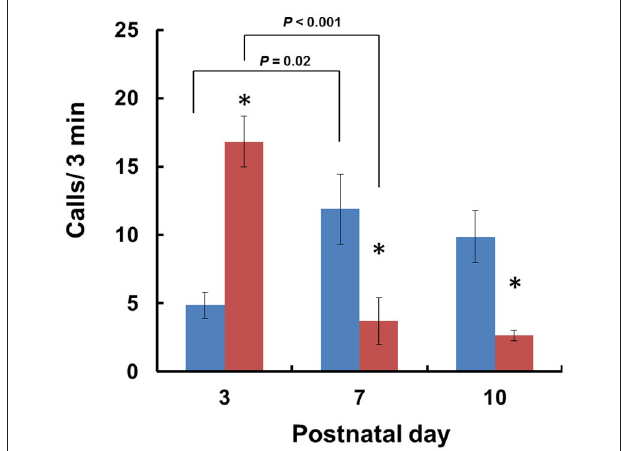
FIGURE 1 | Development of isolation-induced USV production in Cd157 + / + and Cd157 − / − mouse pups. The number ( n = 10–15) of ultrasonic calls were measured in wild-type ( C57BL/6 : blue) and Cd157 − / − (red) pups at PNDs 3–10. Data are given as the means ± S.E.M. Two-way ANOVA with the post-hoc Tukey’s multiple comparison test was evaluated. * P < 0.05 from Cd157 + / +